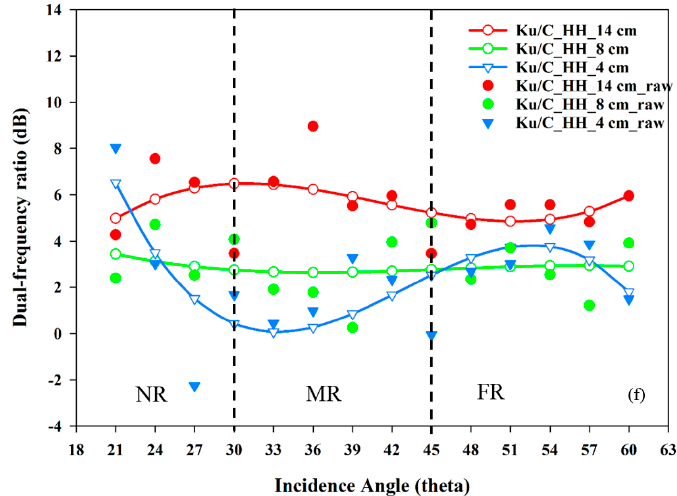
Figure 7. Derived (Ku-, X-), (X-, C-) and (Ku-, C-) VV and HH dual-frequency ratios ( γ DFR ) from 14 cm, 8 cm and 4 cm snow covers on FYI: ( a , b ) Ku- and X-band VV and HH γ DFR ; ( c , d ) X- and C-band VV and HH γ DFR ; and ( e , f ) Ku- and C-band VV and HH γ DFR . Dual-frequency ratio trend lines are cubic fits. Colored points represent dual-frequency ratios from measurement points. Vertical black dotted lines partition near-range (NR), mid-range (MR) and far-range (FR) incidence angles.